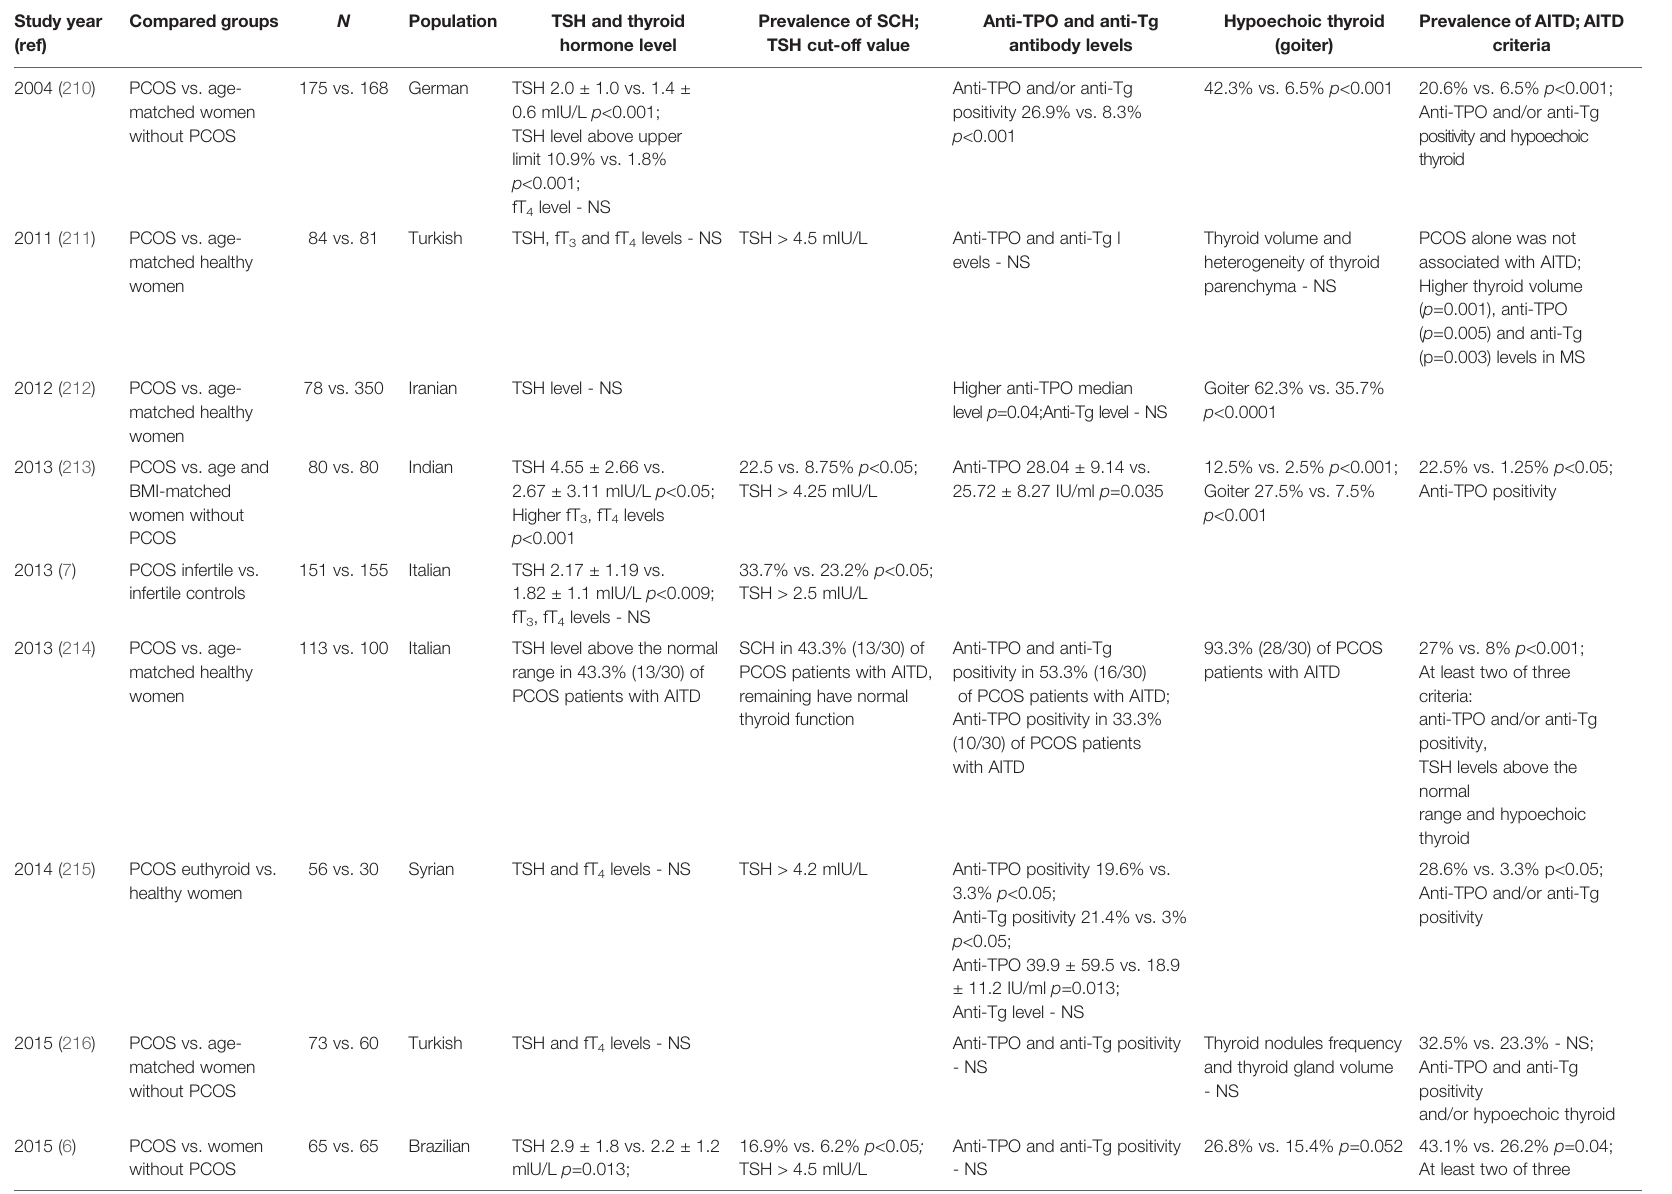
TABLE 3 | Joint prevalence of SCH and AITD in women with